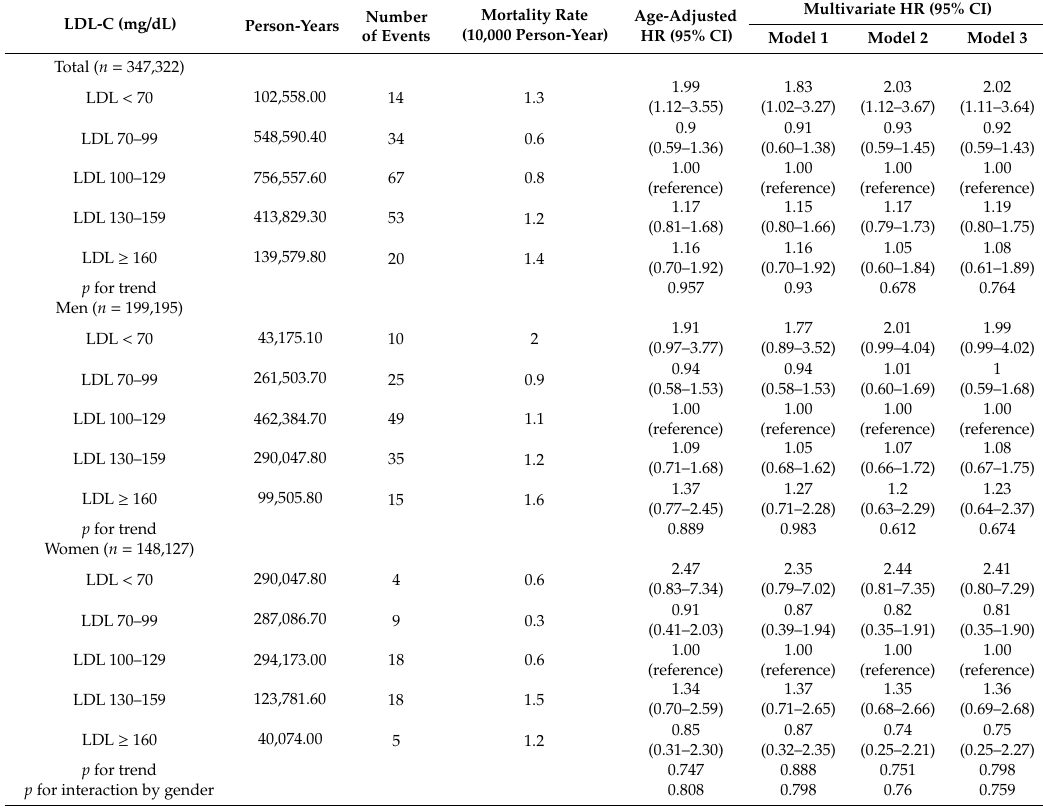
Table 3. Risk of cardiovascular disease mortality according to baseline LDL-C levels excluding subjects who died within 3 years of follow up in Kangbuk Samsung Health Study.